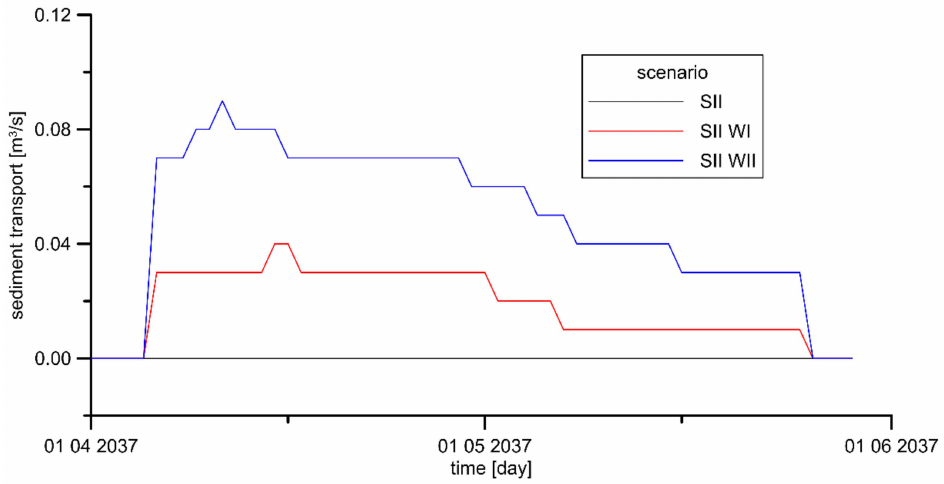
Figure 10. Transport of sediments through the Gniew Barrage in scenarios without flushing (SII) and with flushing (SII WI and SII